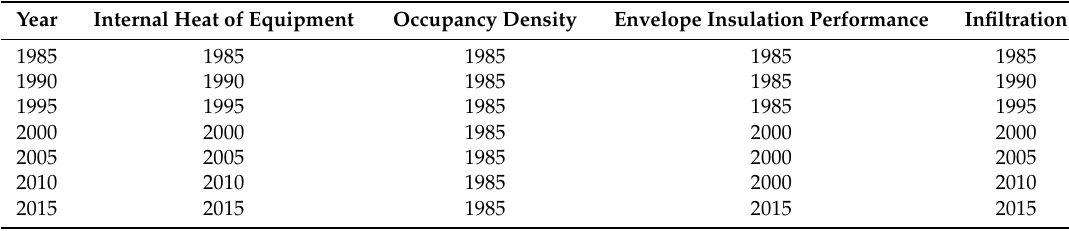
Table 5. Items in Scenario I and input values applied by